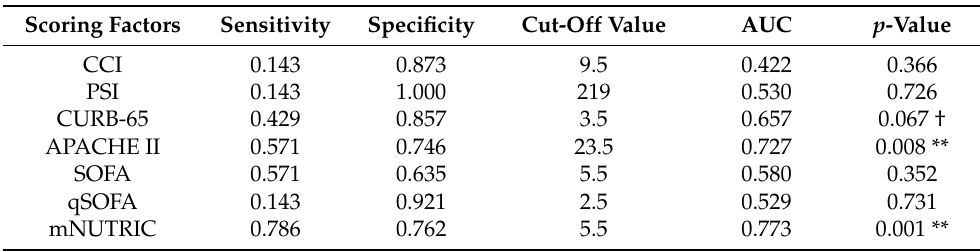
Figure 3. ROC curve analysis for predictability of treatment outcome between different clinical prediction rules. Table 5. Comparison of cut-off value, sensitivity, specificity, AUC, and p -value between severity scoring factors for treatment outcome